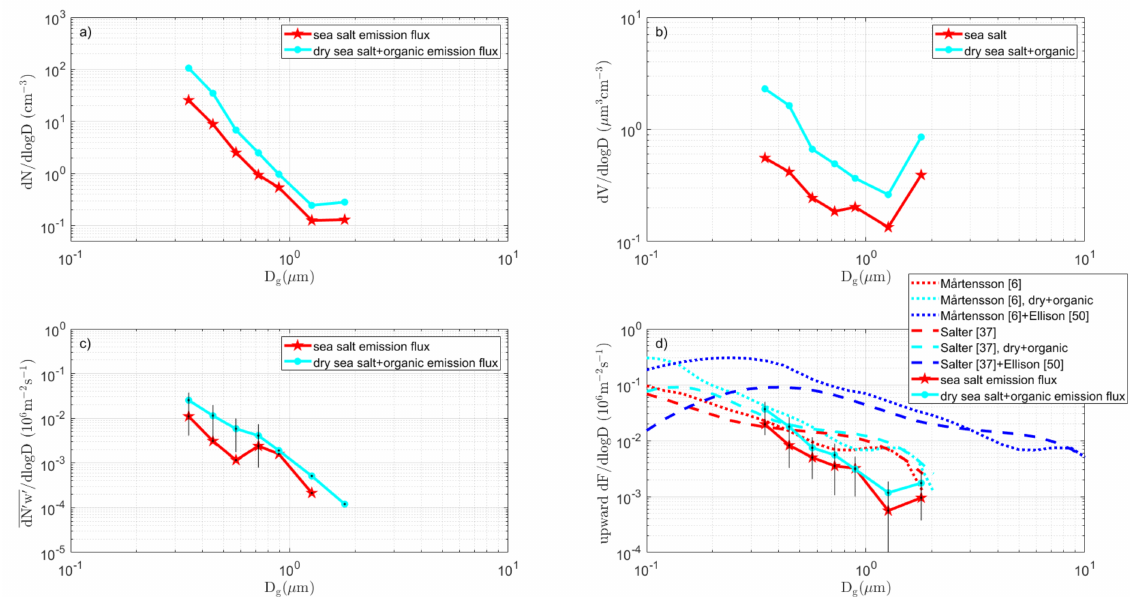
Figure 8. As in Figure 6, except the graphs for the Kalmar Strait sector (0–145 ◦ ). The 0.5 to 2.5 µ m diameter range for the pristine droplets (blue curves) in Figure 6d corresponds to 0.2 to 0.5 µ m dry diameter (cyan curves, sea salt, and organic surfactants). Below this range, the Mårtensson model shows a higher emission, while above this range, the Salter model shows a larger emission of sea spray. This applies to the average wind speed and temperature for data in the coastal sector ( U = 7.6 m/s, mean water temperature = 13.5 ◦ C). When comparing the observed heated flux (presumably sea salt only) with the Mårtensson and Salter sea salt parameterizations (red dotted and red dashed curves, respectively), we found that they fell within the error bars from about 0.4 to 1 µ m dry diameter. If we similarly compared the parameterization curves for sea salt plus organic surfactants (cyan curves), we found that they fell within the range of the observed fluxes of unheated but dried (presumably salt plus organic surfactants) from about 0.3